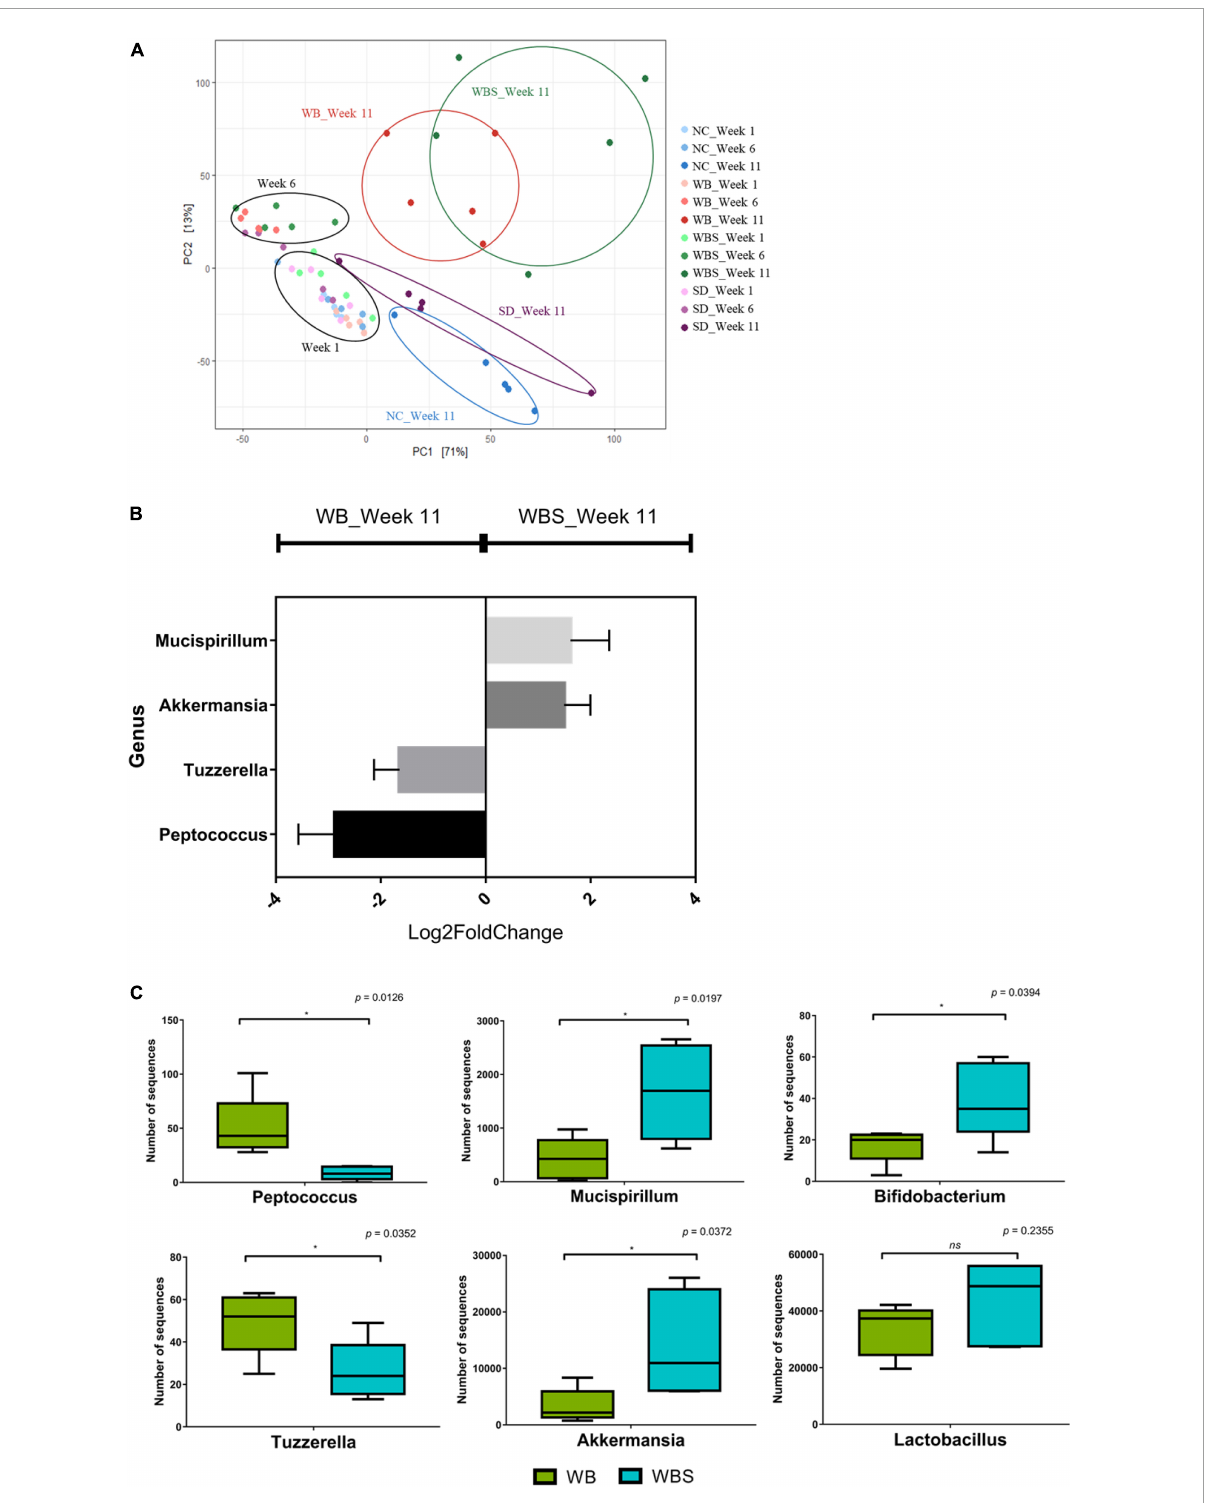
FIGURE6 Microbiome analysis of fecal samples from the in vivo mouse model of all groups. (A) Redundancy analysis (RDA) plot of each group at weeks 1, 6, and 11 using Bray-Curtis dissimilarity. (B) Differential abundance analysis in genus level using DESeq2. (C) Boxplot of comparative composition analysis of Peptococcus , Tuzzerella, Mucispirillum , Akkermansia, Bifidobacterium , and Lactobacillus at week 11 in the WB and WBS groups. WB: mouse feeding group with yeast-fermented white bread, WBS: mouse feeding group with 40% sourdough-supplemented white